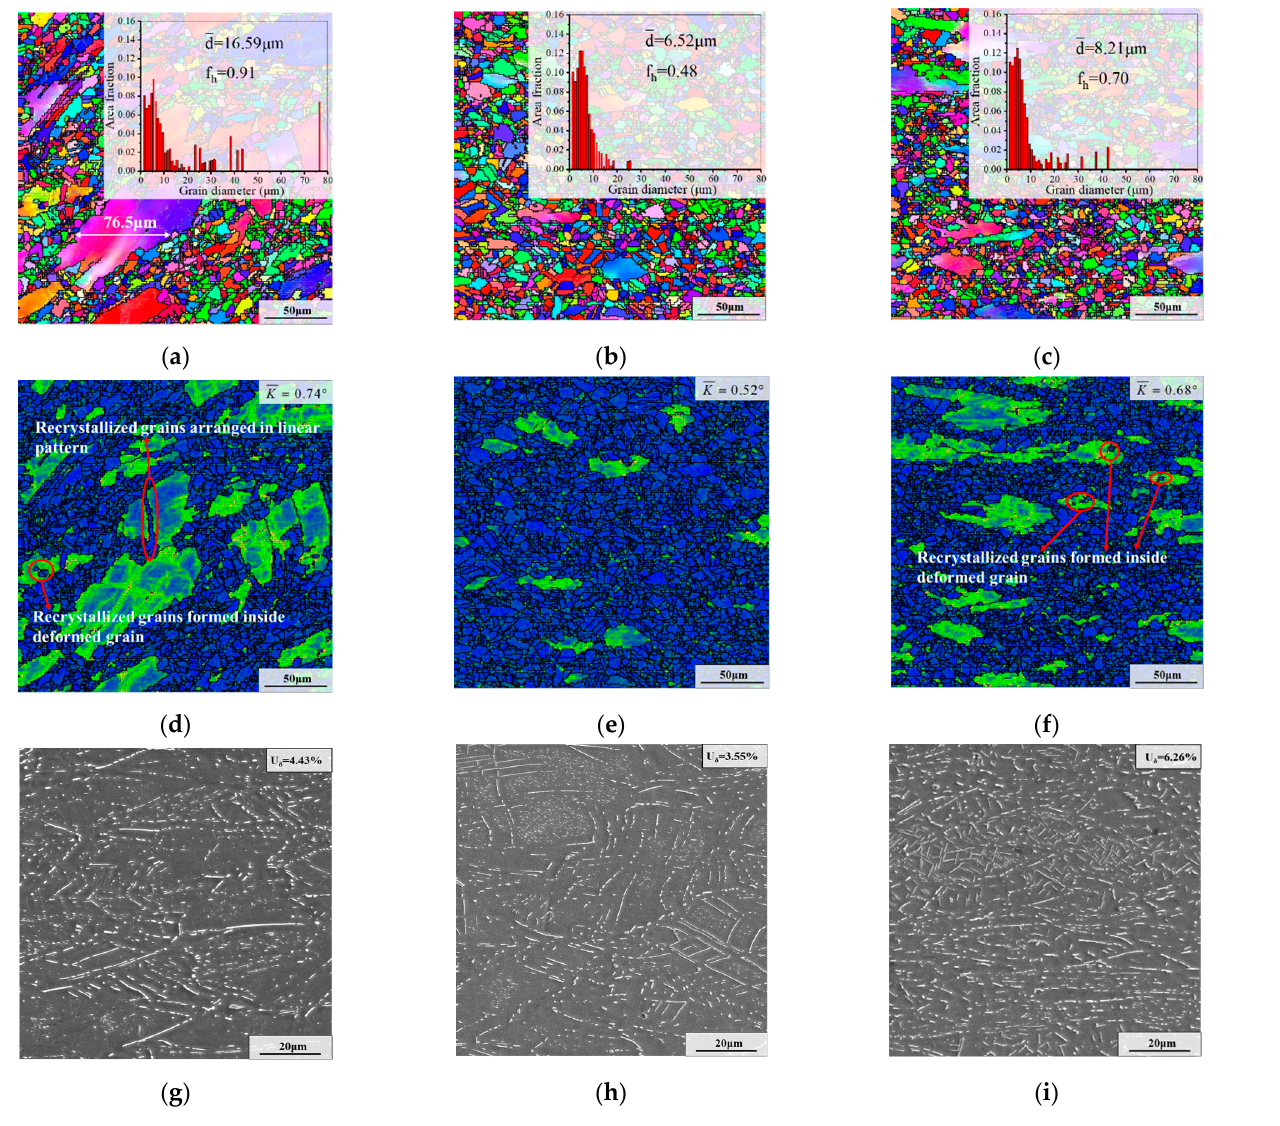
Figure 10. Microstructures after the second annealing stage with different deformation temperatures of: ( a , d , g ) 950 ◦ C; ( b , e , h ) 980 ◦ C; ( c , f , i ) 1010 ◦ C. (The strain rate is 0.1 s − 1 , and the true strain is